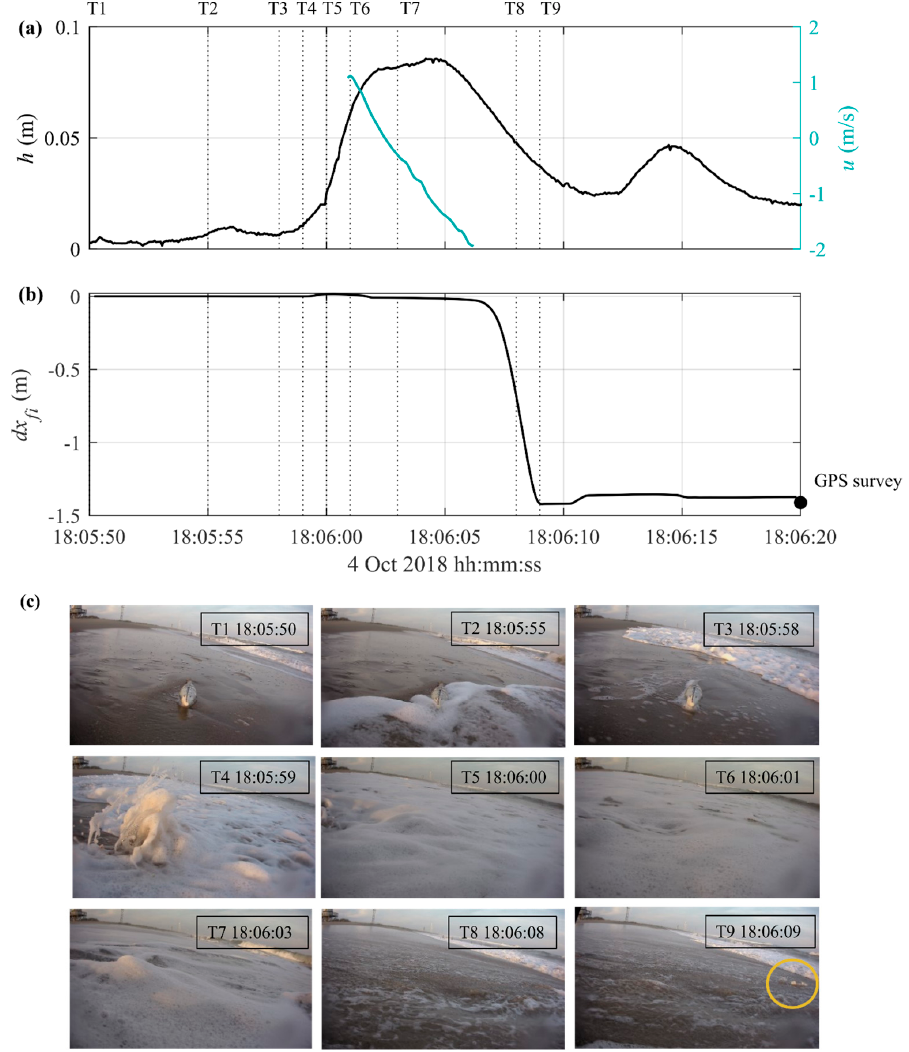
Figure 18. Example of hydrodynamics and munition (81-mm-nf) response to a swash event. ( a ) Measured water level and flow velocity at station 2. ( b ) IMU derived munition migration and final GPS munition position. ( c ) Frames of the munition response at times T1–T9 collected by the UC video imagery.